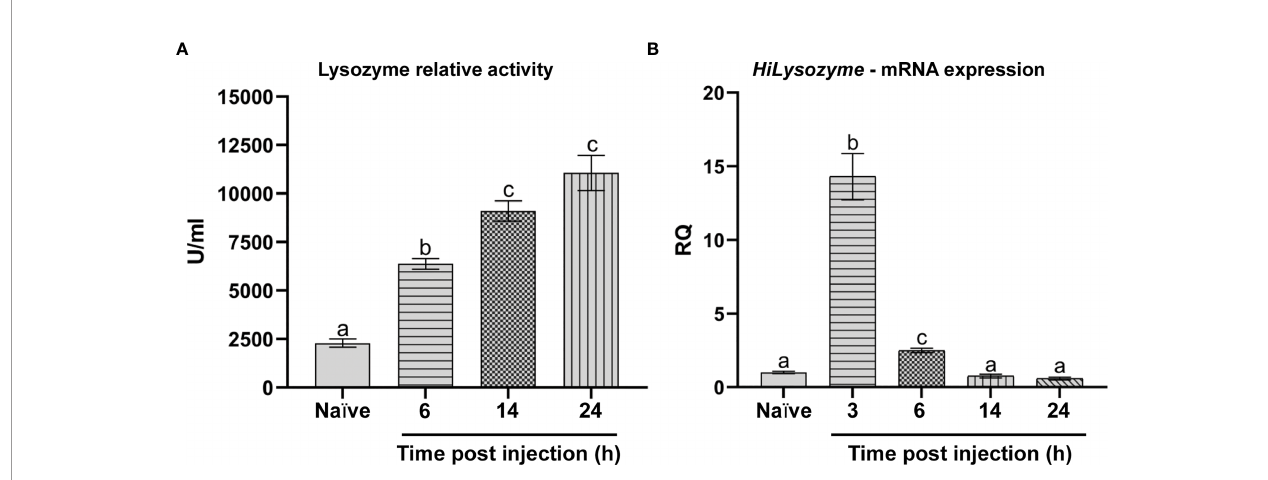
FIGURE 6 | Lysozyme activity and HiLysozyme expression. (A) Lysozyme relative activity in the hemolymph of naïve and infected larvae at different time points. (B) HiLysozyme mRNA levels in hemocytes of naïve and infected larvae at different time points. Naïve larvae starved for 6 and 3 hours were used as controls for the activity and the expression of lysozyme, respectively. Values represent mean ± s.e.m. Different letters indicate statistically signi fi cant differences among treatments (One-Way ANOVA: A ) F 4-10 = 128.1, p < 0.0001; B ) F 4-10 = 107.2, p <